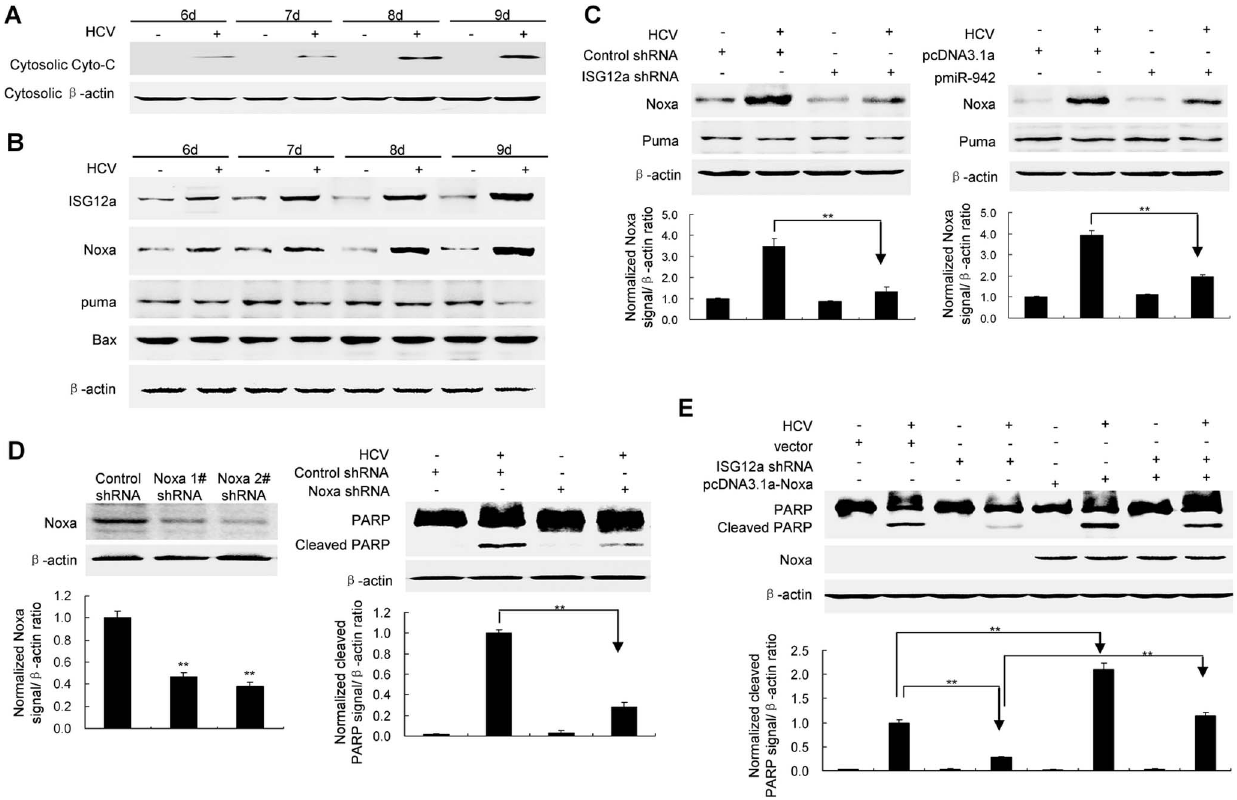
Figure 7. Induction of Noxa contributes to ISG12a-mediated apoptosis. ( A ) Detection of cytosolic cytochrome c. HLCZ01 cells were infected with HCV at MOI of 0.1. Cytosolic cytochrome c was detected by western blot. ( B ) The cells were treated as described in part A. ISG12a, Noxa, Puma and Bax were detected by western blot. ( C ) Silencing of ISG12a or overexpression of miR-942 decreased Noxa expression. HLCZ01 cells were transfected by pcDNA3.1-ISG12a shRNA or pcDNA3.1-miR-942, followed with HCV infection at MOI of 0.1 for 9 days. Noxa and Puma were detected by western blot receptively. ( D ) Silencing of Noxa inhibited HCV-induced apoptosis. HLCZ01 cells were transfected by pcDNA3.1-Noxa shRNA or control vector, followed with HCV infection at MOI of 0.1 for 9 days. Noxa and PARP cleavage was detected by western blot. ( E ) Noxa overexpression reversed the inhibition of apoptosis of ISG12a-silenced HLCZ01 cells. HLCZ01 cells were transfected by ISG12a shRNA or control vector, followed with pcDNA3.1-Noxa transfection. Then the cells were infected with HCV at MOI of 0.1 for 9 days. The cells were collected and PARP cleavage was detected by western blot. If not stated otherwise blots are representative of three independent experiments.